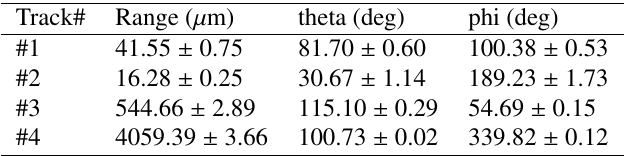
Table 1. The range and angle data of related tracks. Track#2 and #3 stopped in the upstram of the emulsion plate and track#4 ended in the downstream of plate#6.